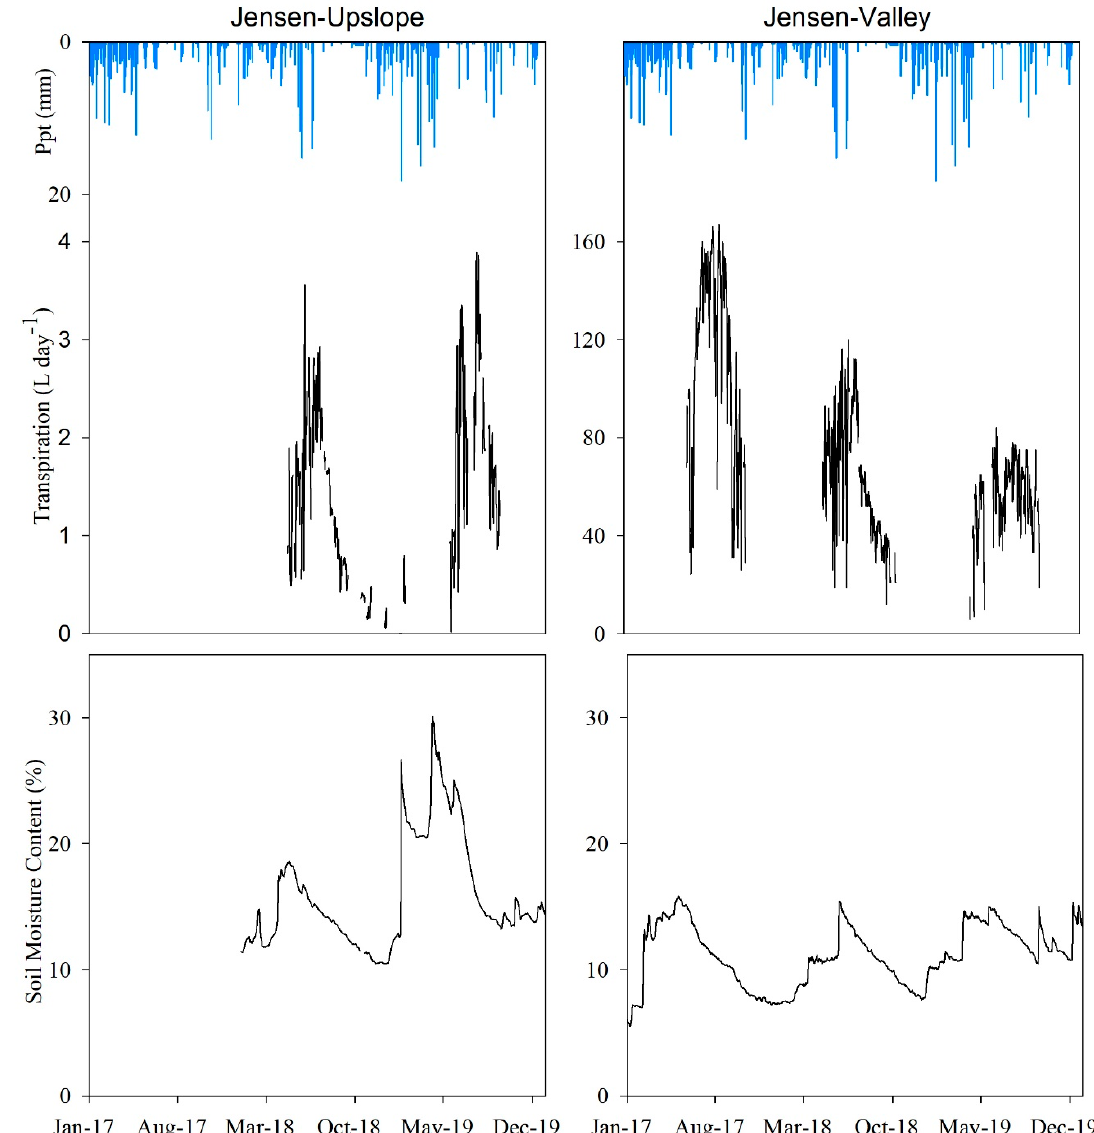
Figure 7. Juniper daily averaged transpiration and soil moisture content, 0 to 0.8 m ( θ tot ) response to precipitation (Ppt) inputs in the Jensen-Upslope and Jensen-Valley monitoring locations at Jensen WS.